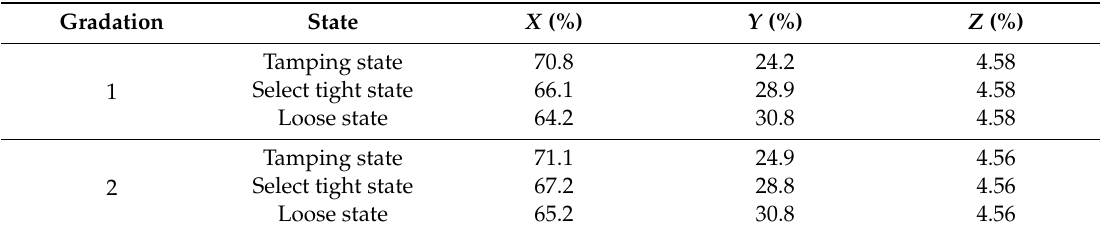
Table 9. Calculation results under di ff erent filling methods.